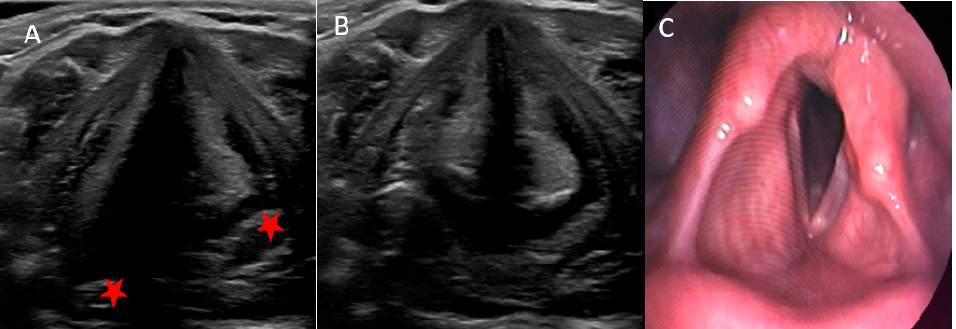
Figure 3. An example of left-sided paralysis, visible asymmetry of VFs and arytenoids (red star) and lack of movement of the left-hand VFs in adduction and abduction in TLUS ( A , B ) and during the videolaryngoscopy ( C ).